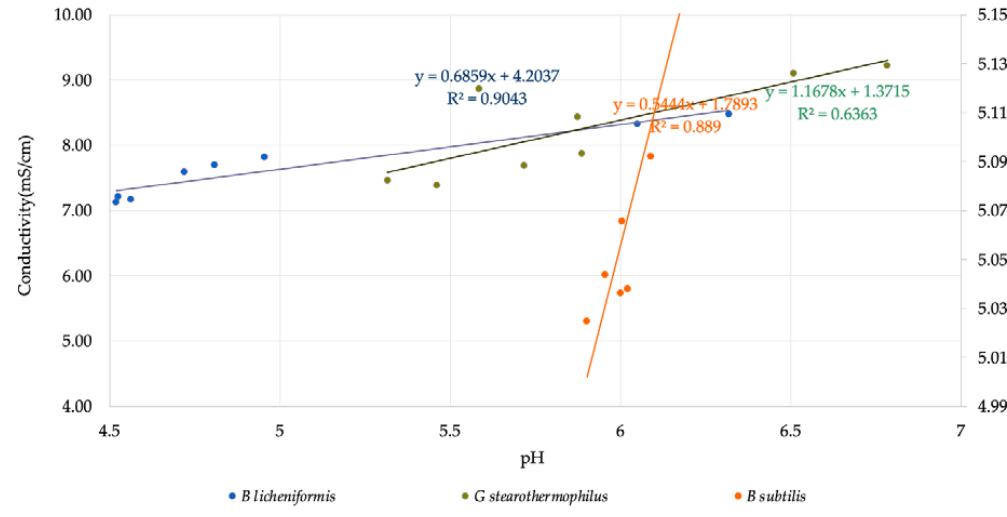
Figure 3. Correlation curve for conductivity and pH .